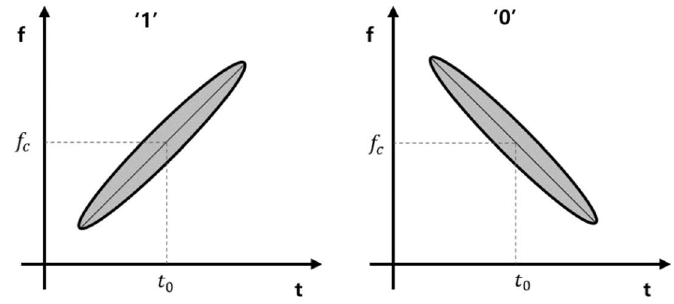
Figure 3. Band-limited bit signal on the spectrogram.